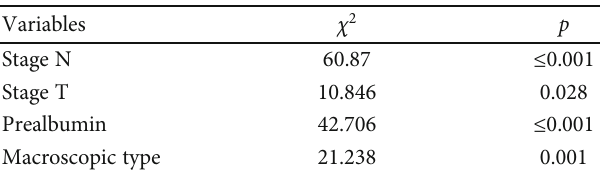
Table 3: Multivariate logistic analysis of the with and without GOO groups for related factors.